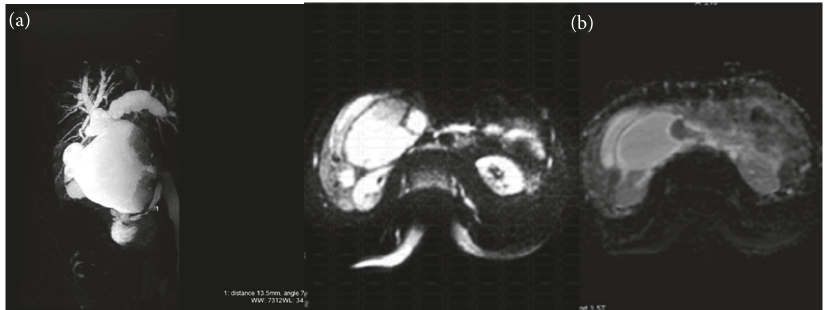
Figure 3: Biliary MRI. (a) Front MIP reconstruction of the bile ducts and cystic mass. (b) The diffusion sequence showed high signal intensity of intracystic bud and the apparent diffusion coefficient (ADC) map shows low signal intensity of lesions characteristic of tumor lesion.